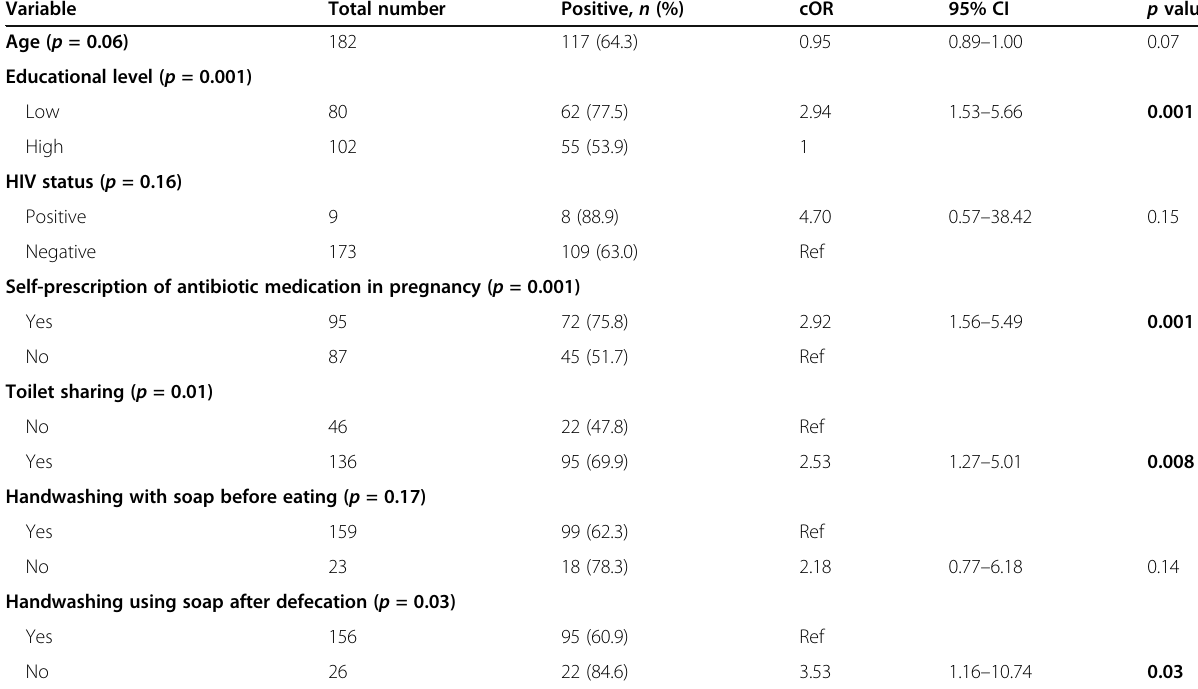
Table 3 Socio-demographic, clinical, and hygienic factors associated with ESBL-E fecal carriage by bivariate analysis Variable Total number Positive, n (%) cOR 95% CI Age ( p = 0.06)